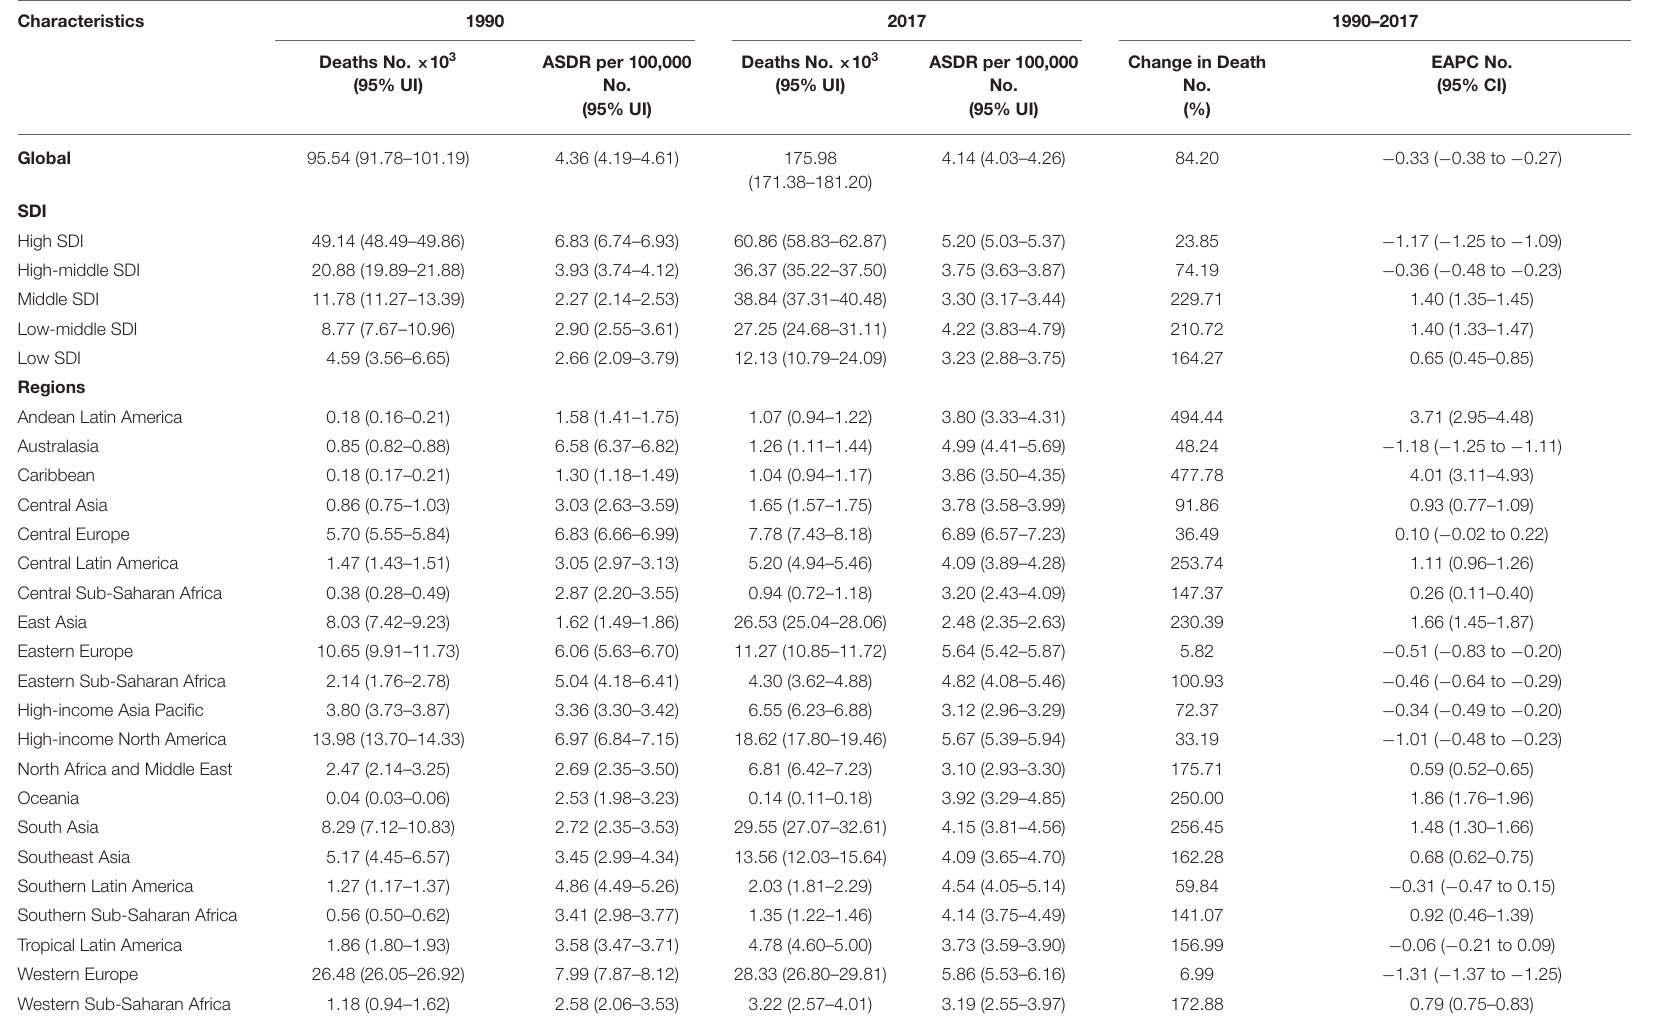
TABLE 2 | The death of ovarian cancer, and its temporal trends from 1990 to 2017.